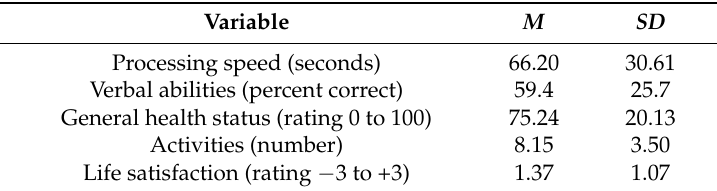
Table 2. Means and standard deviations of analyzed